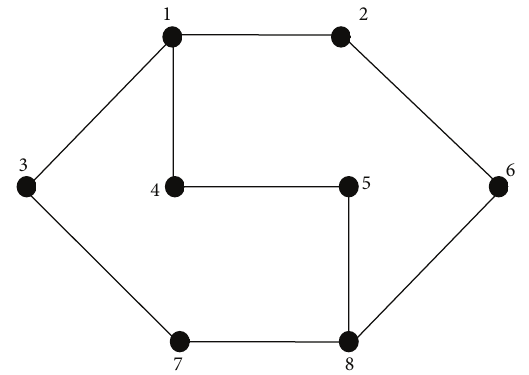
Figure 3: Example of a simple network model with eight nodes and nine